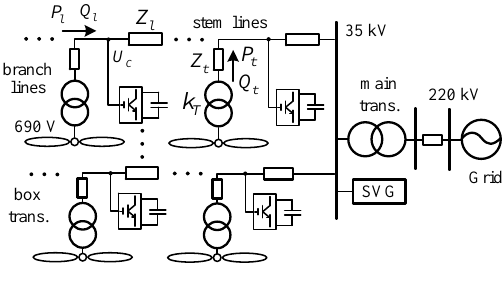
Figure 1. Radial structure of wind farm.